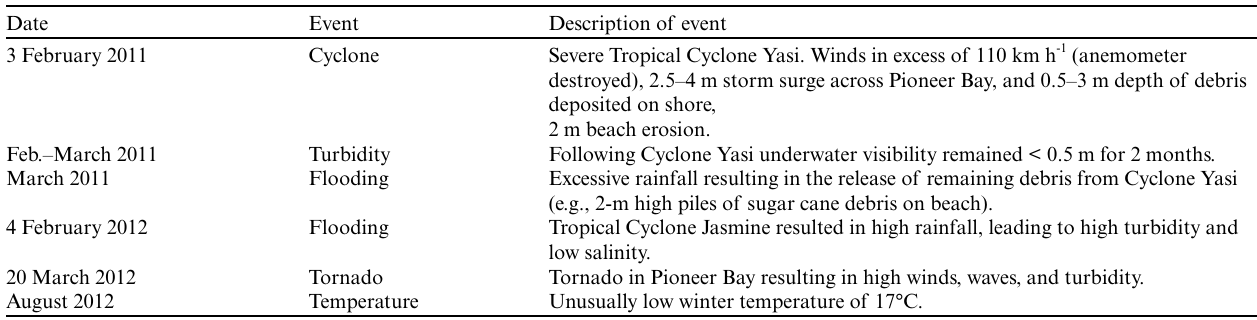
Table 1 . List of severe climatic events affecting Pioneer Bay, Orpheus Island between February 2011 and August